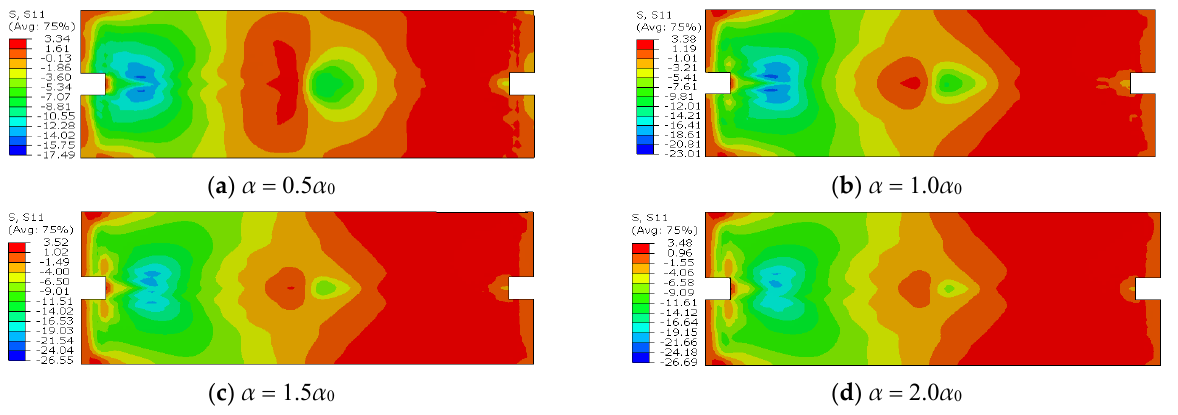
Figure 15. Load – displacement curves for different α values.